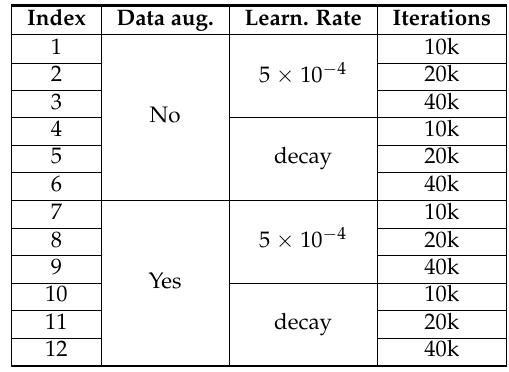
Table 1. Hyperparameter values and combinations.